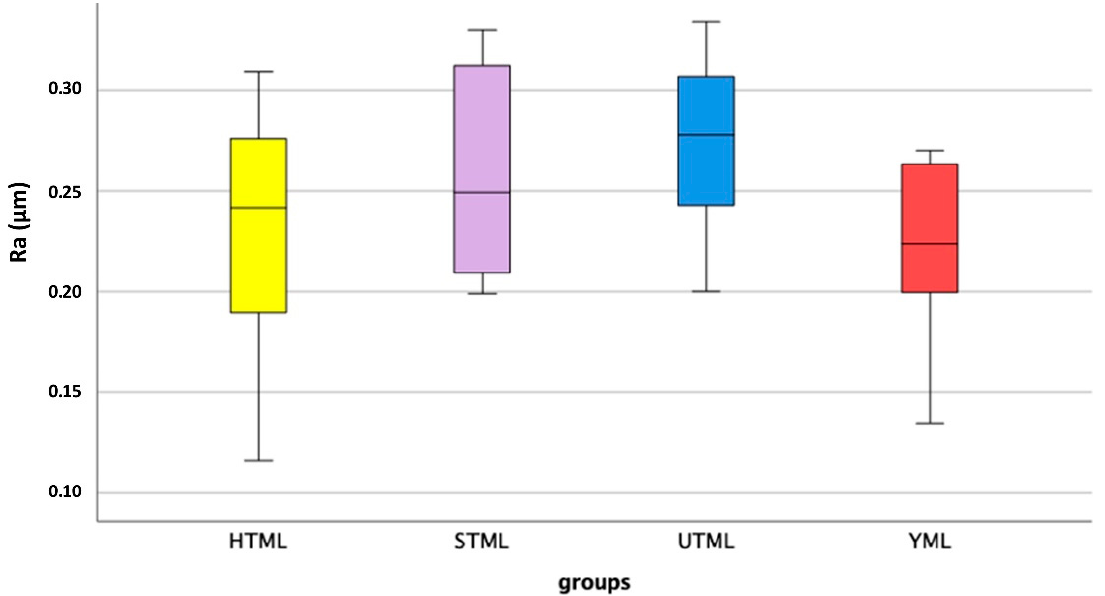
Figure 8. Roughness values R a (µm) after aging: median, interquartile range (IQR, 75th percentile (Q1), 25th percentile (Q3)), upper whisker (Q1–1.5 IQR), lower whisker (Q3–1.5 IQR).